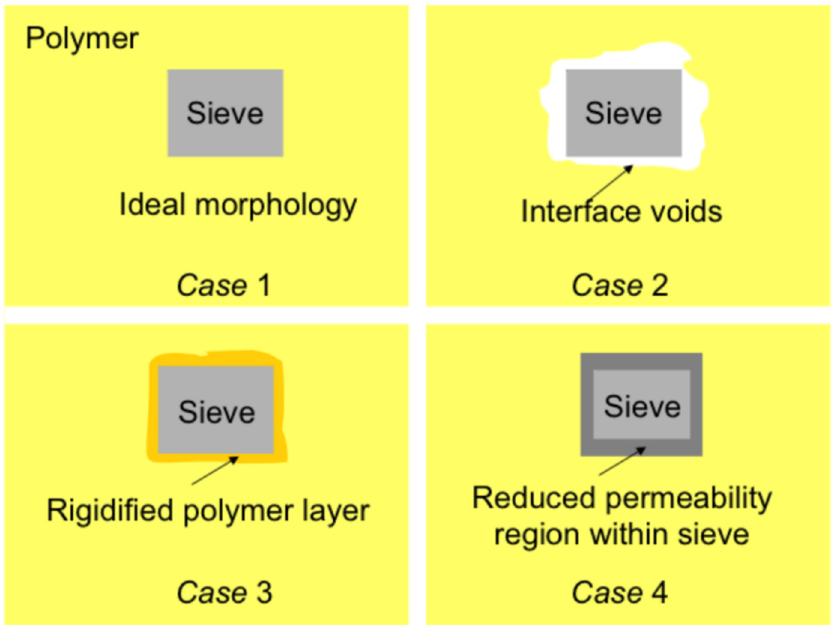
Figure 3. Four scenarios of mixing a polymer with inorganic fillers. Reprinted with permission from [17], copyright 2007 Elsevier.